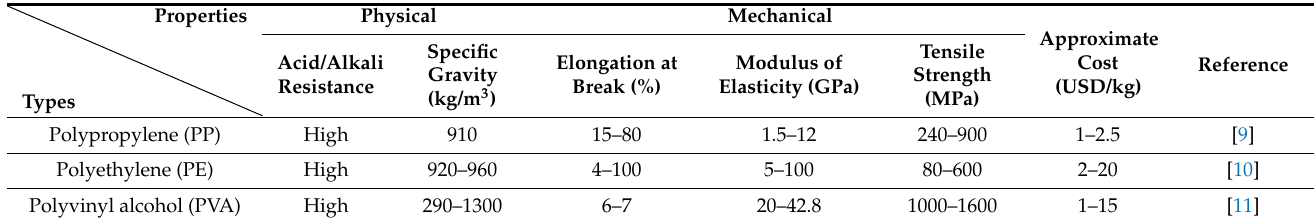
Table 1. Comparison between different types of synthetic